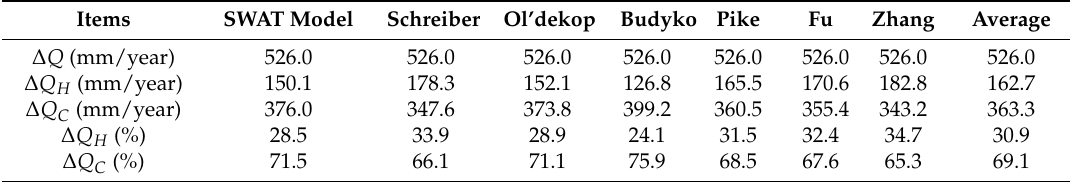
Table 7. Verification of the hydrological modeling approach (Soyang Dam upper basin).